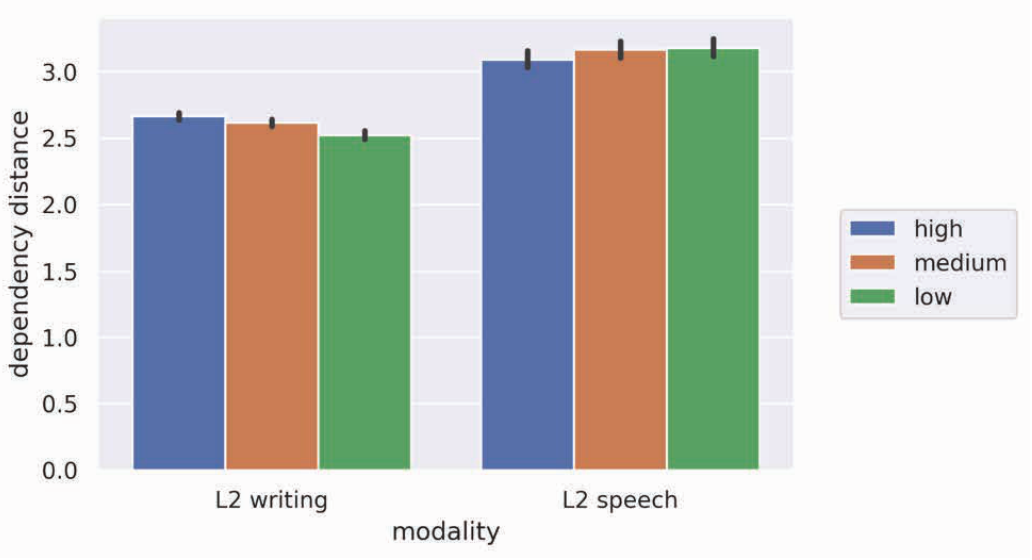
F igure 2: Dependency distances across proficiency levels in L2 writing and speech